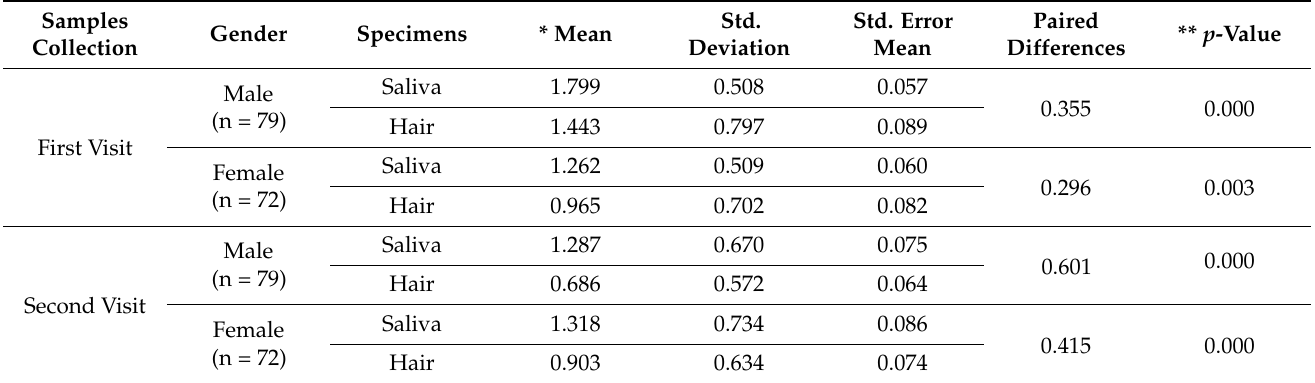
Table 4. Gender wise comparison of cortisol levels in saliva and hair specimens of the participating students at two time intervals